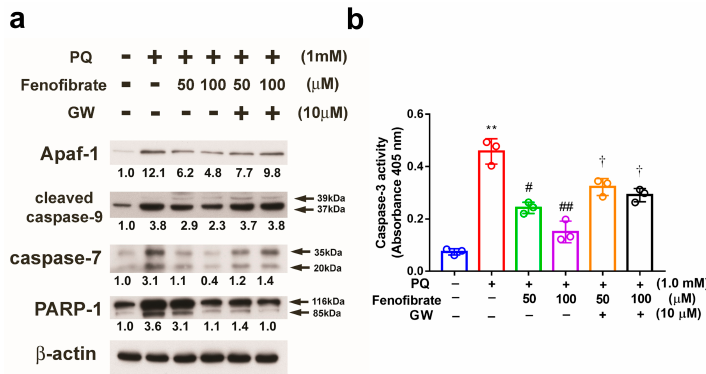
Figure 8. Effects of fenofibrate on the expression of paraquat (PQ)-induced apoptosis-related proteins assessed by western blot analysis. RF/6A cells were pretreated with a high or low dose of fenofibrate for 1 h, then exposed to 1 mM PQ for 24 h. In GW6471 (GW) treated groups, the cells were incubated with 10 µ M GW6471 for 1 h before fenofibrate treatment. ( a ) The expression levels of anti-apoptotic protease activating factor-1 (Apaf-1), cleaved caspase-9, caspase-7, and poly (ADP-ribose) polymerase-1 (PARP-1) are shown. The fold changes compared to those in control group are presented under the protein bands. β -actin was used as an internal control. ( b ) Caspase-3 activity. (** p < 0.01 between the control group and 1 mM PQ-stimulated group using Mann–Whitney U-test; # p < 0.05, ## p < 0.01 compared to only 1 mM PQ-stimulated group using Kruskal–Wallis test with post hoc Dunn’s test; † p < 0.05 between GW6471 treated group and fenofibrate treated group (the same concentration of fenofibrate) using Mann–Whitney U-test; n = 3 in each group.).